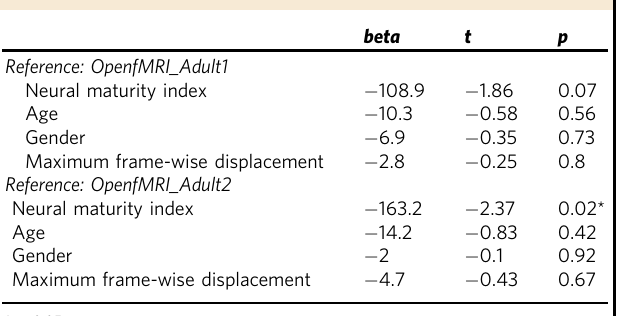
Second, we examined the relationship between STN activation during stopping and SSRT in the ABCD dataset. We found a negative correlation between STN activation in stopping and SSRT (rSTN: r = − 0.20, p = 0.005, Cohen ’ s d = 0.41, lSTN: r = − 0.22, p = 0.005, Cohen ’ s d = 0.45; Pearson ’ s correlation) (Supplementary Fig. 8). Multiple linear regression analyses with SSRT as the dependent variable and STN activation, age, gender, and maximum head motion displacement as independent variables, con fi rmed that STN activation was the most robust predictor of SSRT (rSTN: p = 0.0006, lSTN: p = 0.0002; general linear regression) (Supplementary Table 22).